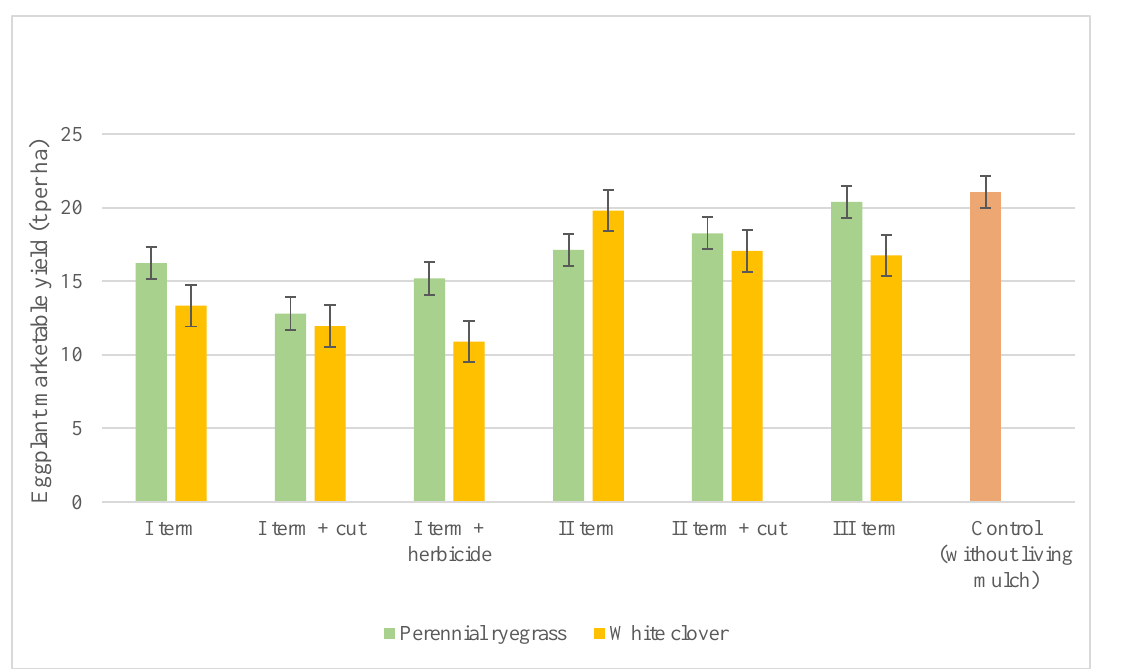
Figure 3. The effect of living mulches species, sowing term and living mulches management on eggplant marketable yield [t·ha − 1 ].